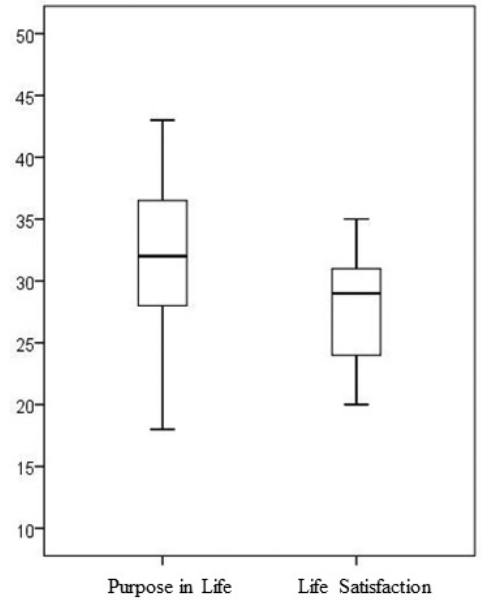
Figure 2. Descriptive statistics of purpose in life and life satisfaction of the elderly who practice hydrogymnastics. Maringá, Paraná, Brazil,